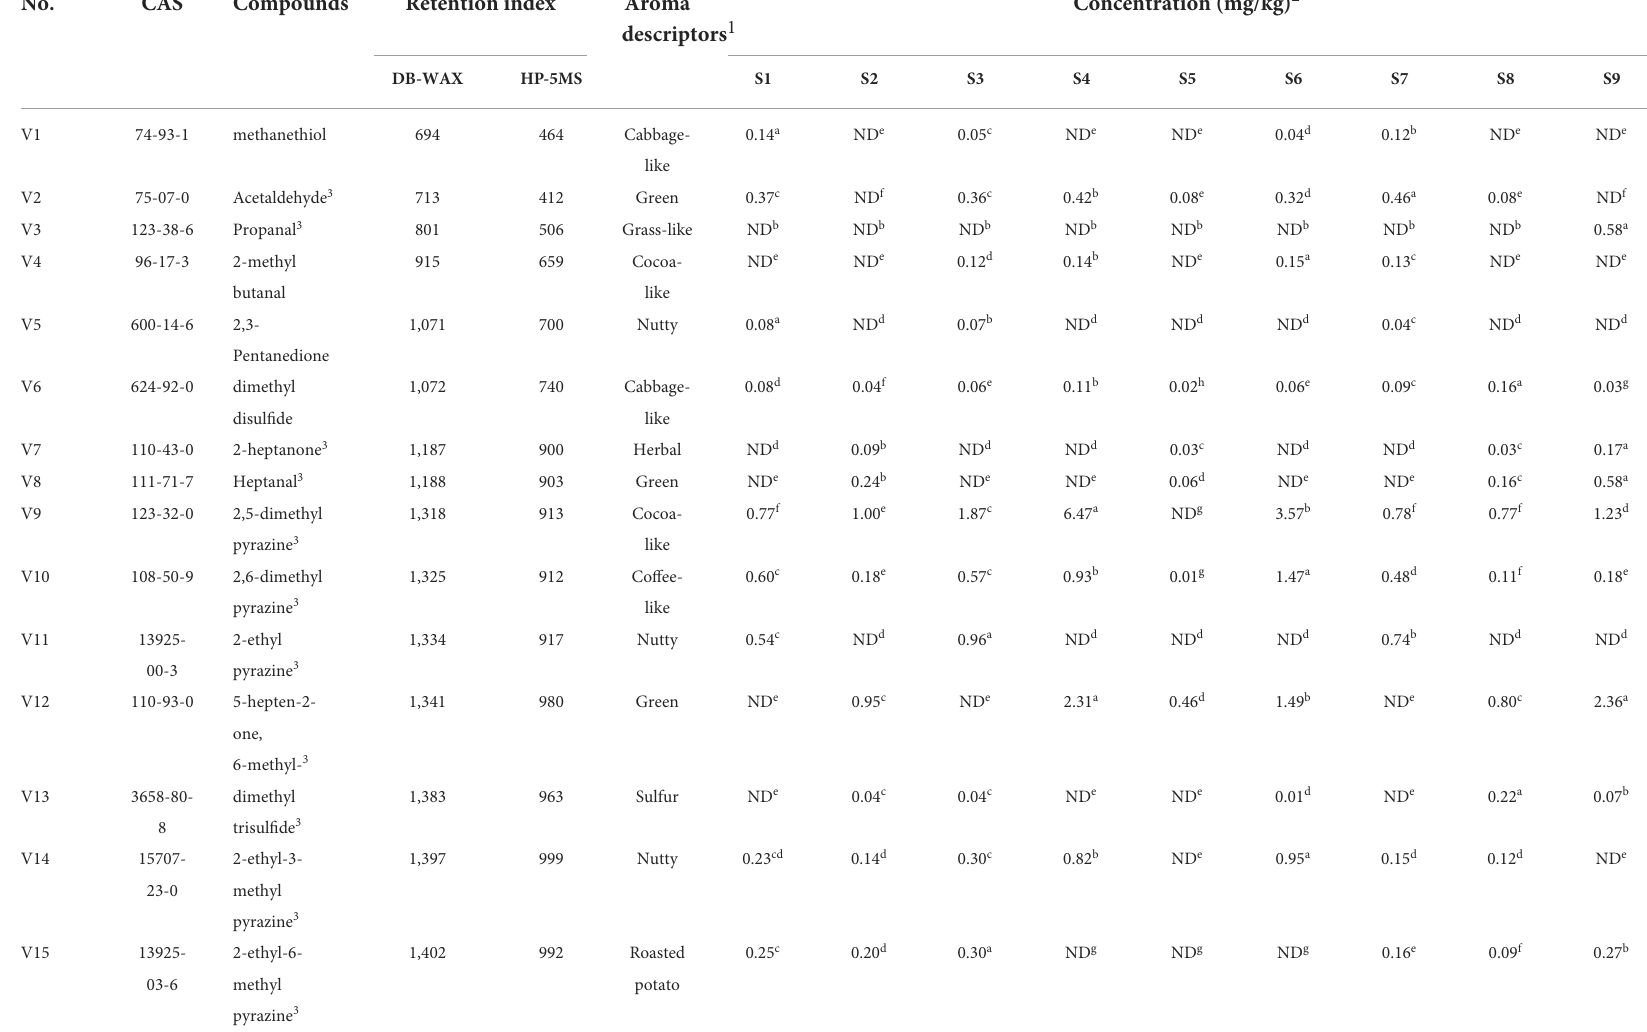
TABLE 1 Aroma compounds and their contents in fragrant rapeseed oils with significant differences ( p < 0.05)